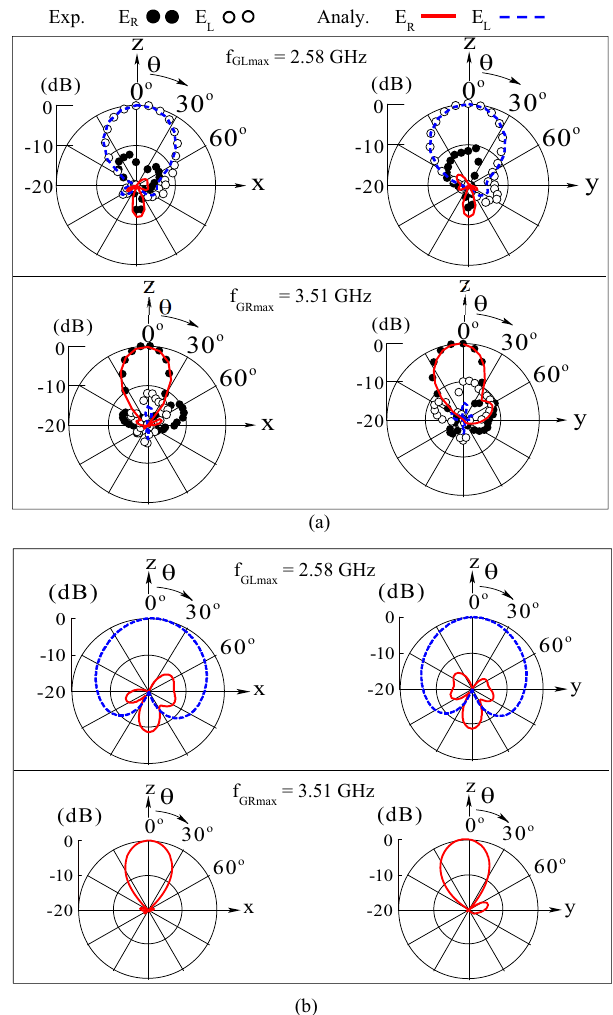
Fig. 8. Normalized radiation patterns at f GLmax =2.58GHz and f GRmax =3.51 GHz. (a) In the presence of a parasitic loop. (b) In the absence of a parasitic